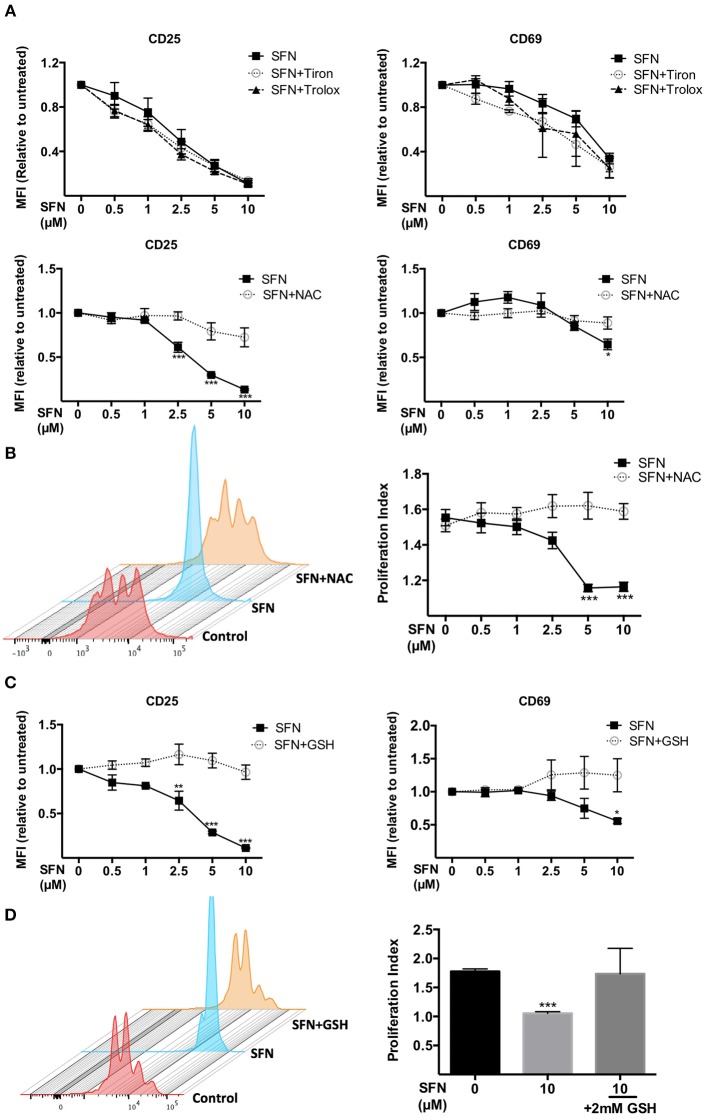
Immunosuppressive effects of SFN were abrogated by thiol-containing antioxidants. (A,C) Expression of CD25 (left) and CD69 (right) in T-cells were analyzed by flow cytometry under the indicated conditions. T-cells in the presence/absence of SFN and (A) Tiron, Trolox (upper graphs), NAC (lower graphs) or (C) GSH were co-stimulated with anti-CD3(20 ng/ml) /CD28(5 μg/ml) antibodies for 1 day. Shown are the MFI ratios of SFN treated to untreated samples (n = 3; mean; SE; *p < 0.05, **p < 0.01, ***p < 0.001). (B,D) T-cell proliferation was detected via staining of CFSE. T-cells were loaded with CFSE, thereafter co-stimulated with anti-CD3 (20 ng/ml)/CD28 (5 μg/ml) antibodies in the absence/presence of SFN without and with addition of exogenous NAC (B) or GSH (D). CFSE signals were measured after 3 days of co-stimulation by flow cytometry. Shown are representative histograms (left) and the proliferation index (right) from three independent experiments (n = 3; mean; SE; ***p < 0.001).